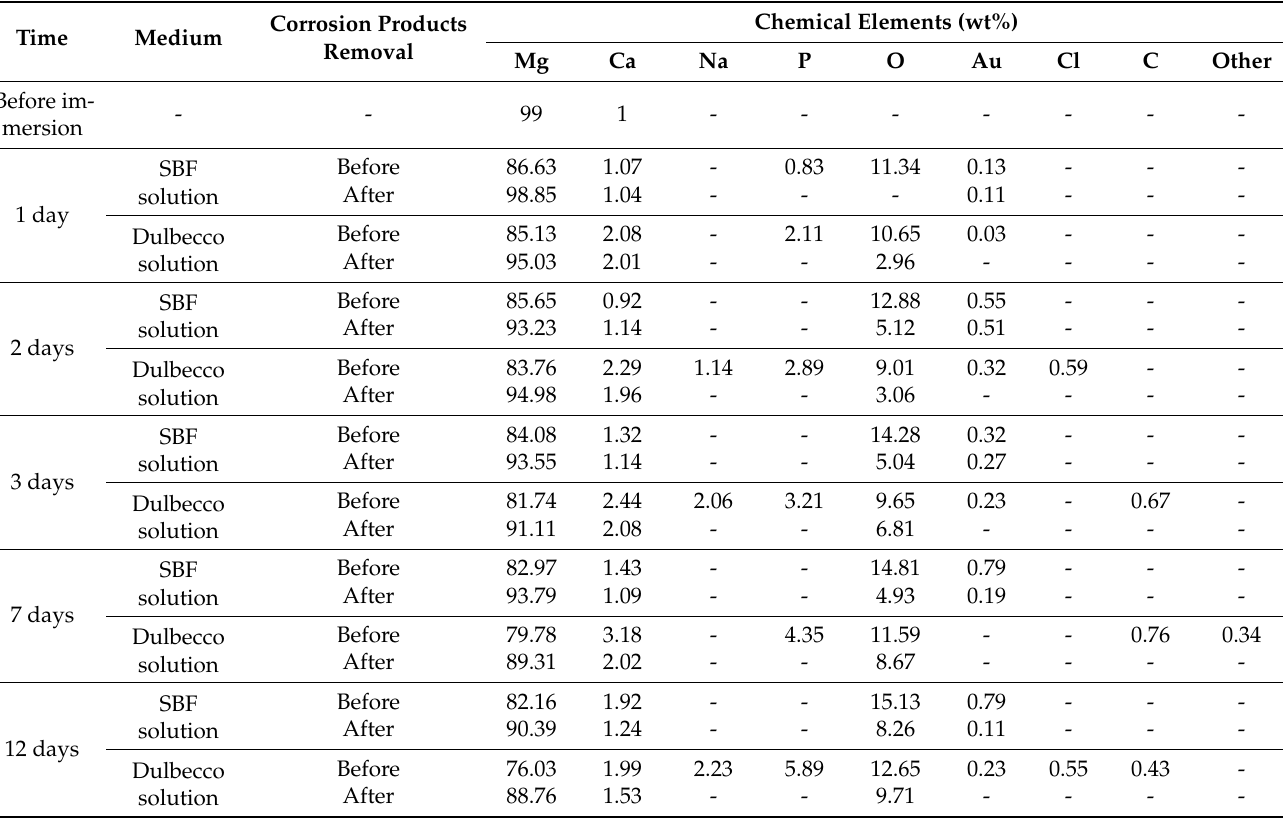
Table 2. EDS results before immersion and after 7 days’